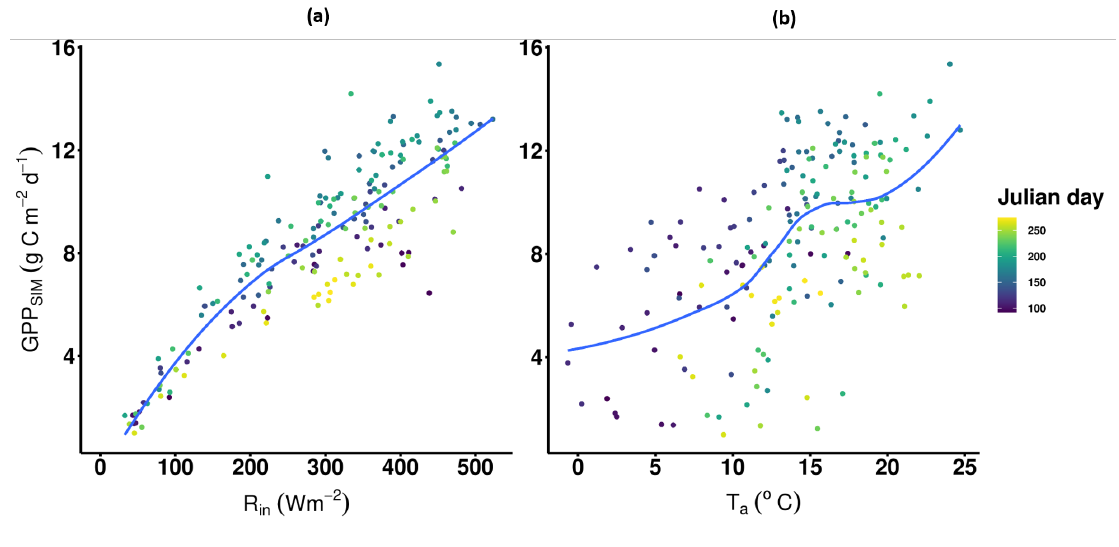
Figure 6. Dependence of simulated gross primary production (GPP SIM ) within the HLS info scenario on ( a ) daily mean incoming shortwave radiation (R in ) and ( b ) daily mean temperature (T a ) during the 2016 vegetation growing season. Values are color-coded by Julian days. Local polynomial regression (loess) was used to show the general trend in the